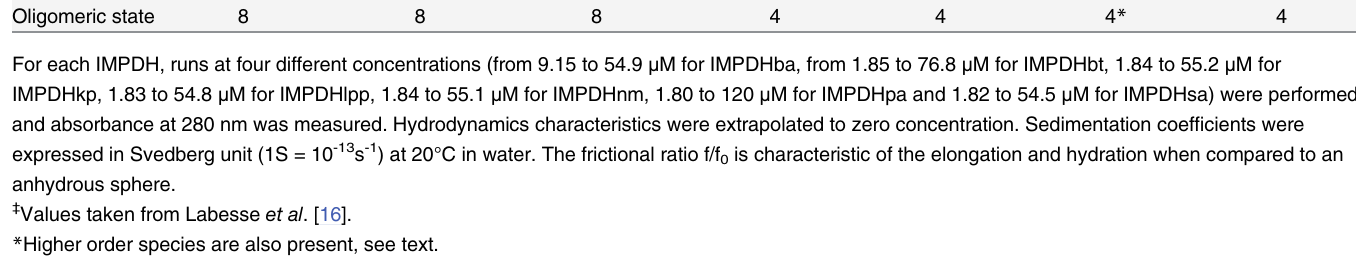
Table 3. Oligomeric state of seven bacterial IMPDHs in their apo form determined by analytical ultracentrifugation. IMPDHlpp